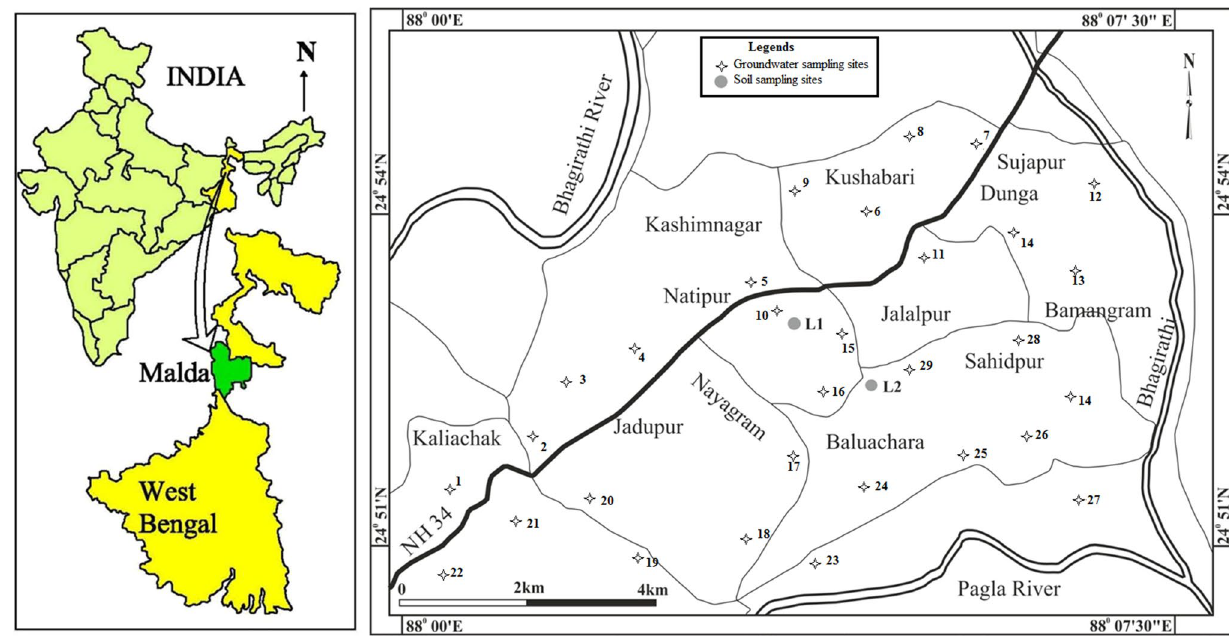
Fig. 1 Location of groundwater and soil sampling sites (L-1: paddy and L-2: wheat) in the Kaliachak block I of Malda district in West Bengal, India selected in this